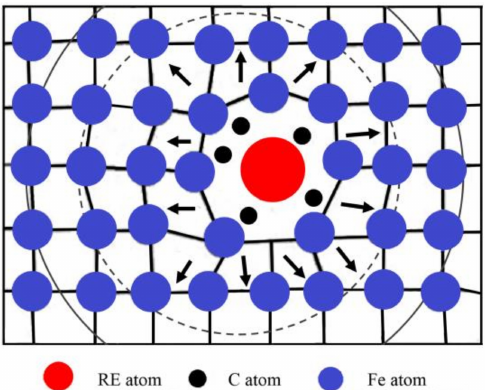
Figure 15. Physical model of an RE solid solution atom in a crystal face in an Fe lattice.